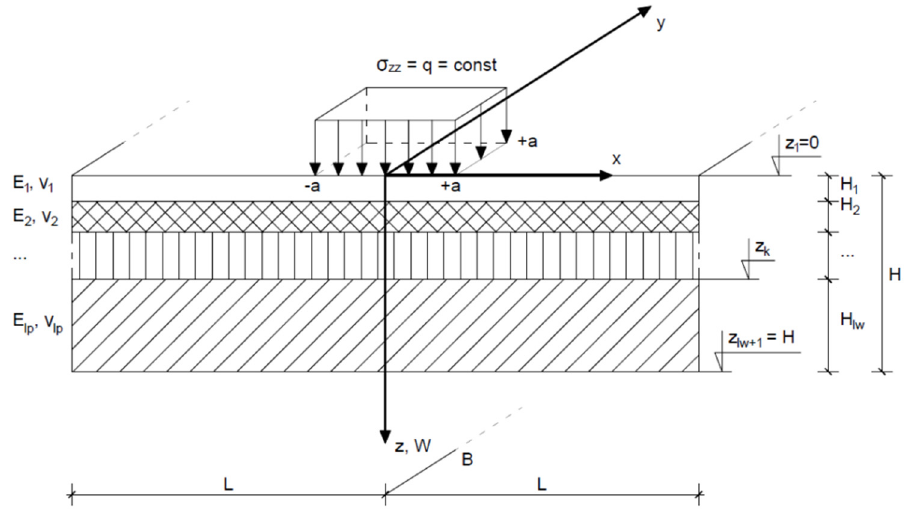
Figure 3. Loading model accepted in the calculations: ρ zz —normal stress; E 1 , E 2 —layer stiffness modules; υ 1 , υ 2 —Poisson’s coefficients; x, y, z—Cartesian coordinates; v, β , U, α —displacement and strain in different directions; H 1 , H 2 . . . H n —layer thickness; z 1 , z 2 , z k —depth and layer